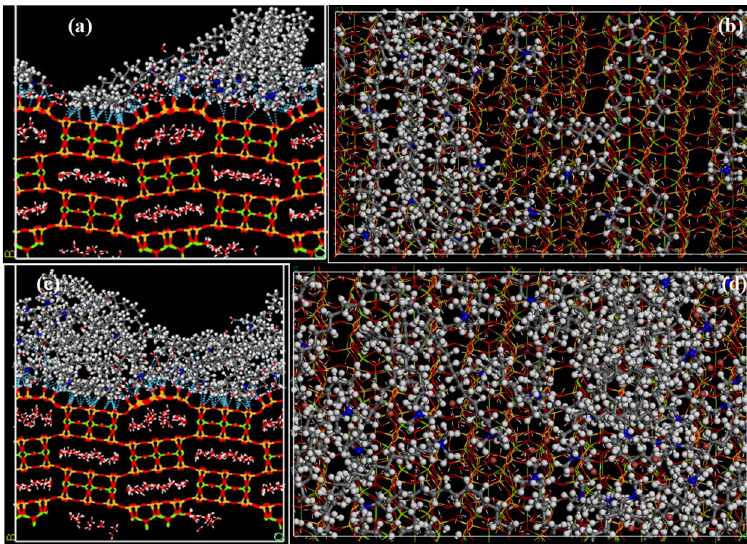
Figure 10. Side ( a , c ) and top views ( b , d ) of the final structures for the monolayer CTAB/SEP and bilayer CTAB/SEP models, respectively 1.25 ns later.